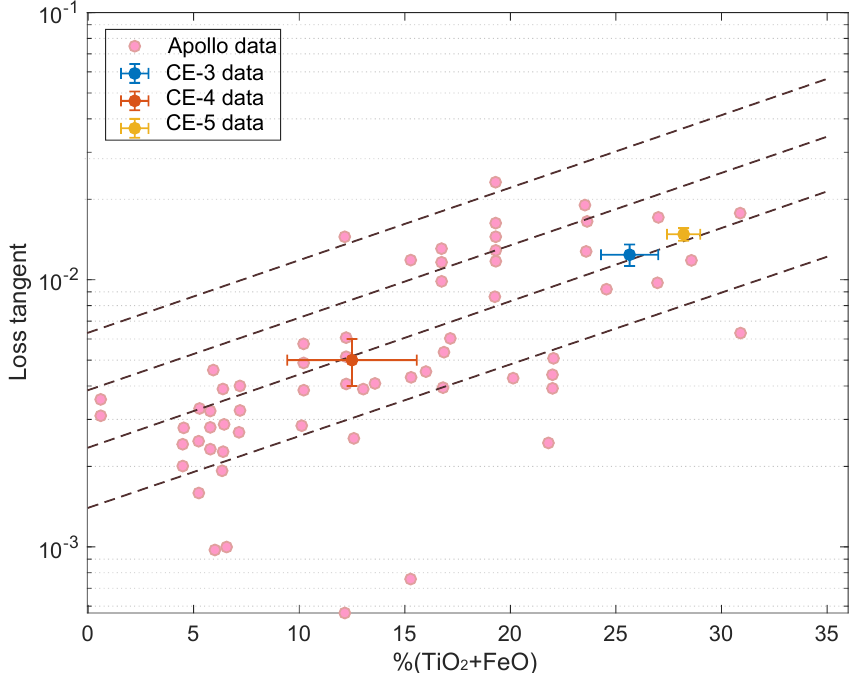
Figure 8. Relationship between the loss tangent and ferrotitanium content (TiO 2 +FeO). The pink dots represent laboratory measurements of Apollo lunar regolith samples (Carrier et al. [4]), while green, red, and yellow represent the results of the loss tangents derived from Chang’E-3, Chang’E-4, and Chang’E-5 radar data,